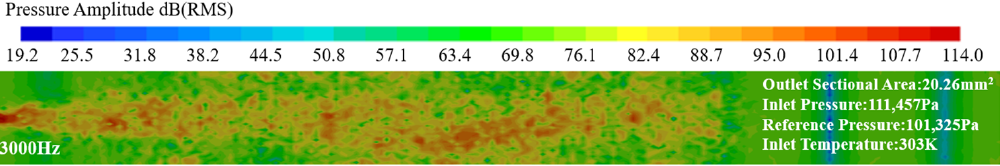
Figure 18. Cloud map of the 3000 Hz near-field sound pressure levels of the equal-diameter